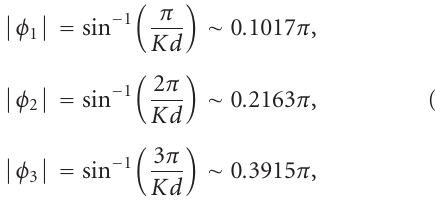
Figure 10: A contour plot of an electron density in a sample dot for Kd =